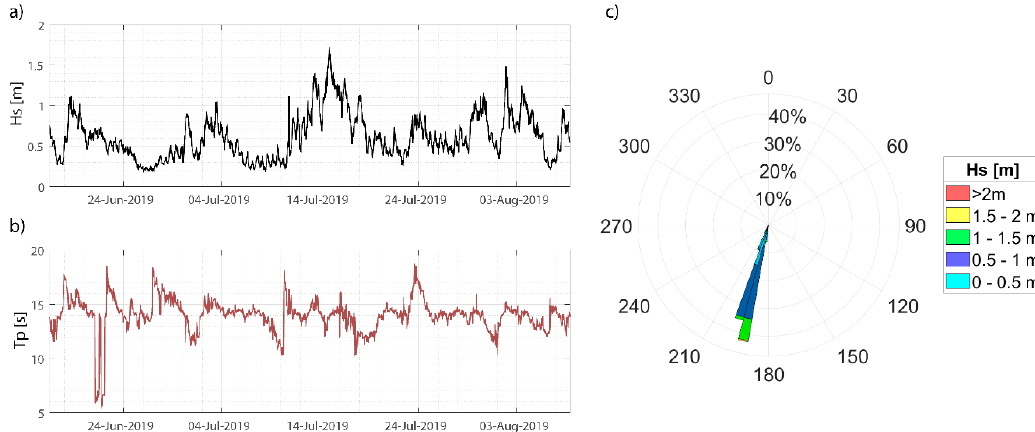
Figure 2. ( a ) Significant wave height (Hs) and ( b ) spectral wave period (Tp) observed during the first six weeks of deployment. ( c ) Wave direction of significant wave heights for the same period.